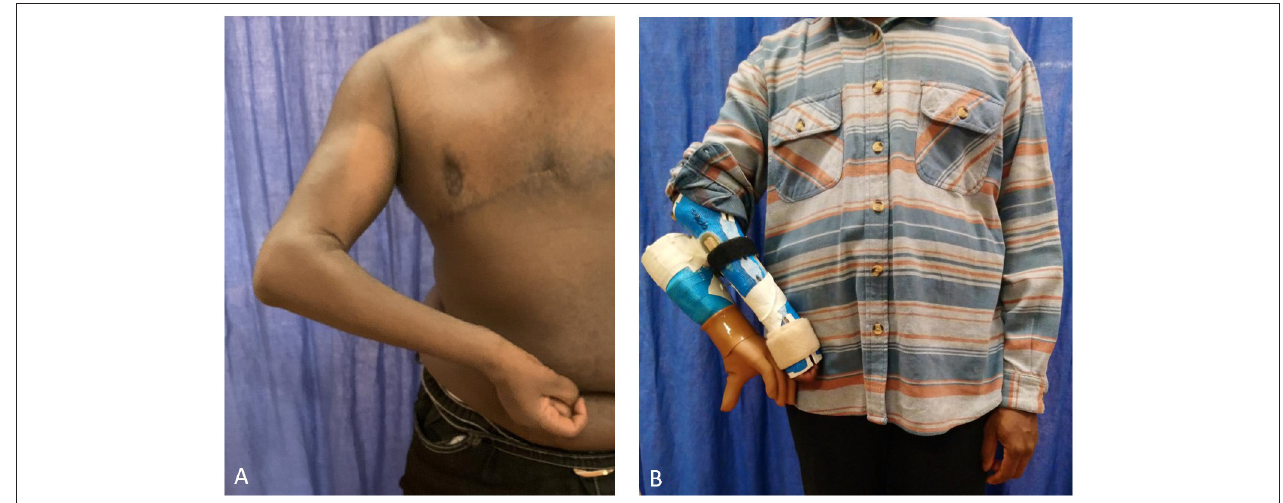
FIGURE 2 | Plexus arm (A) and hybrid prosthesis that is mounted on the paretic arm (B) .